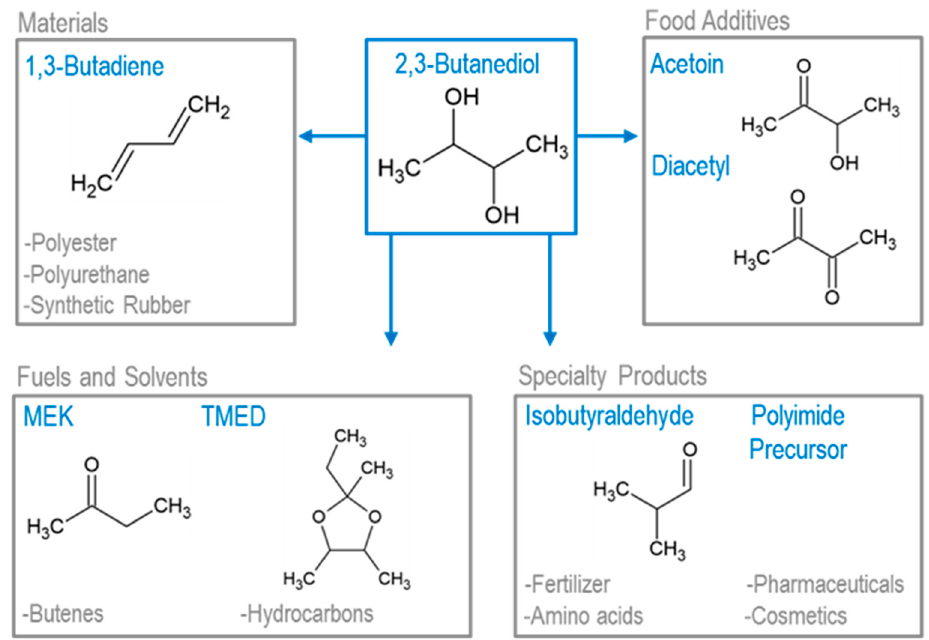
Figure 5. Schematic of potential upgrading possibilities for conversion of 2,3-butanediol (with acetoin highlighted as a food additive) to high-value products.